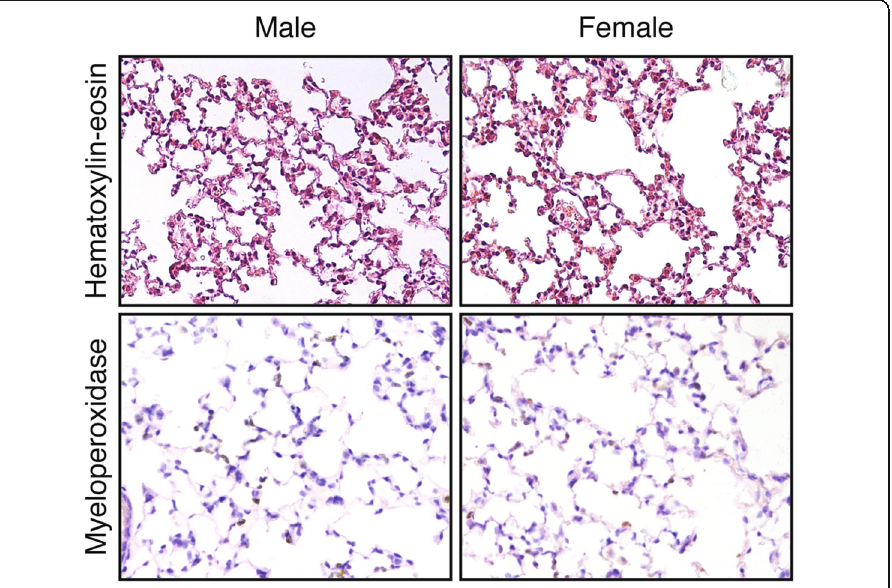
Fig. 1 Representative histological sections stained with hematoxylin-eosin (upper row) or immunostained using an anti-myeloperoxidase (MPO) antibody (lower row) in male and female mice after injurious